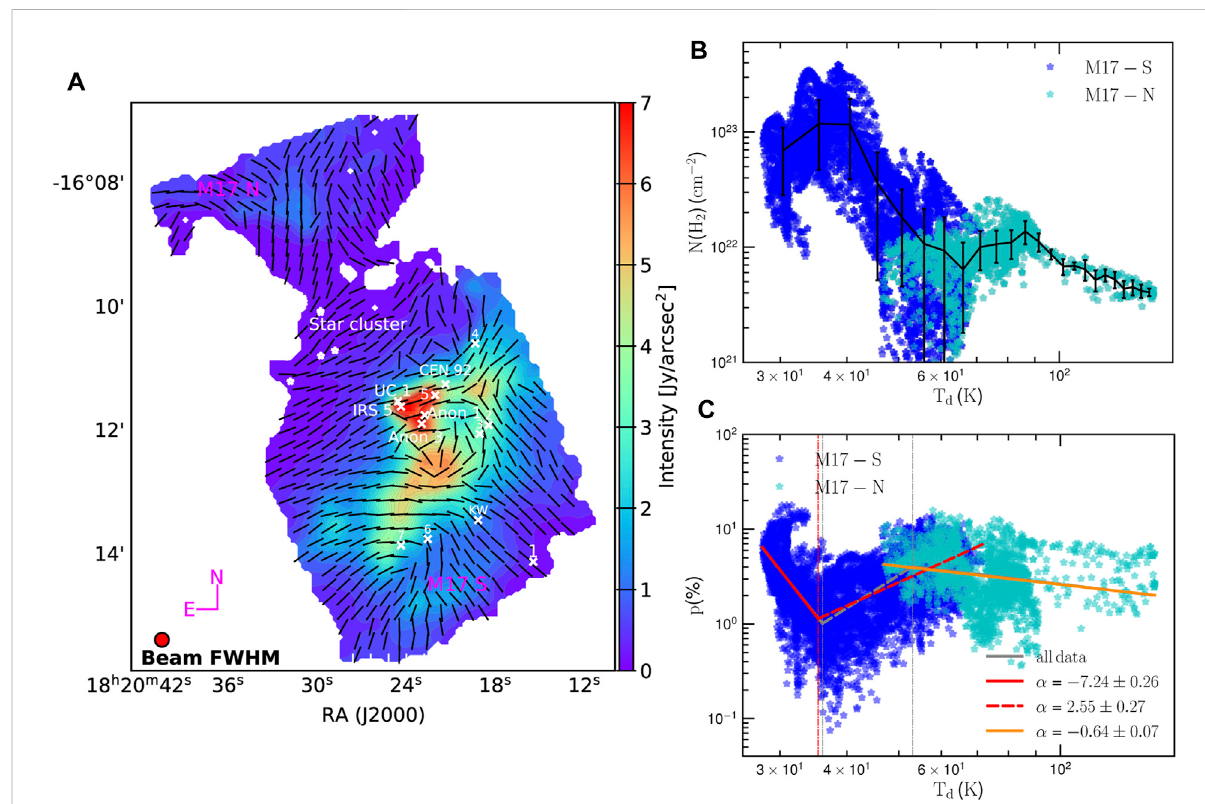
FIGURE 11 (A) SOFIA/HAWC + observations of M17. The color background shows the total continuum intensity (Stokes-I). The black vectors represent the magnetic fi eld morphology. We divided M17 into two sub-regions: M17-N and M17-S. In the M17-S region, IR sources are denoted by the white crosses and numbered. The star cluster NGC 6618 is represented by star symbols. (B) The relation of gas column density vs. dust temperature in the two sub-regions. (C) The relation of polarization degree vs. dust temperature. Error bars connected by a line shows the weighted mean in each binandillustratesthatthelowerdensitygashasahigherdusttemperature.Colorlinesarethe fi ttingtoalldatapoint(thegreyline),toonlyM17-S(the redline),andtoonlyM17-N(theorangeline).ThepolarizationincreaseswithincreasingdusttemperatureinM17-S,whereasitdropstohigher T d and lower N (H 2 ) in M17-N. Figure adopted from Hoang T. D. et al.